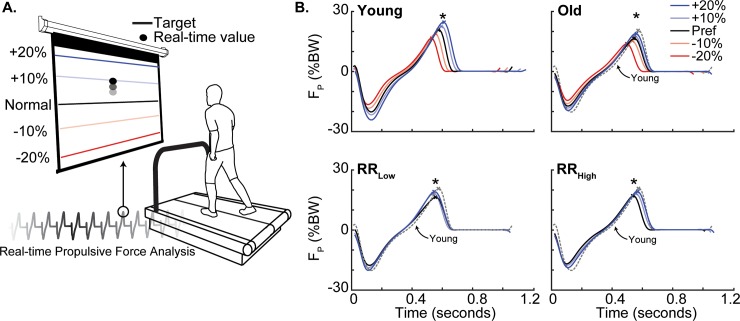
A.) Experimental design using real-time peak propulsive force measurements projected in front of participants with targets representing ±10 and 20% different from preferred. B.) Group average anterior-posterior ground reaction force by condition across time for all young (top left), all old (top right), RRLow (bottom left), and RRHigh (bottom right). Dashed grey lines represent young preferred walking as reference. An X on each curve provides a reference for the timing of peak FP. Asterisks (*) represent a significant main effect (p<0.05) of FP biofeedback on peak propulsive force.